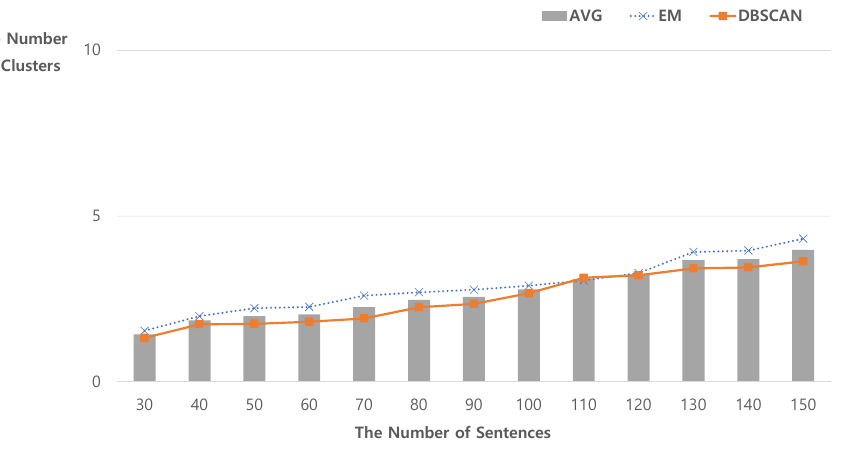
Figure 7. The average number of clusters after 10 runs using EM and DBSCAN algorithms with